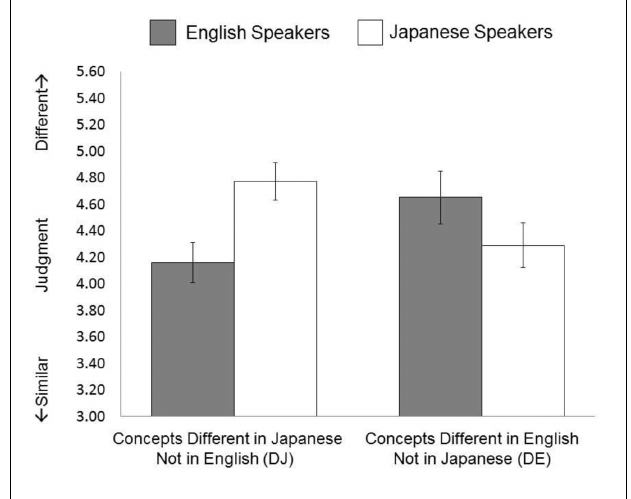
FIGURE 3 | Results of Study